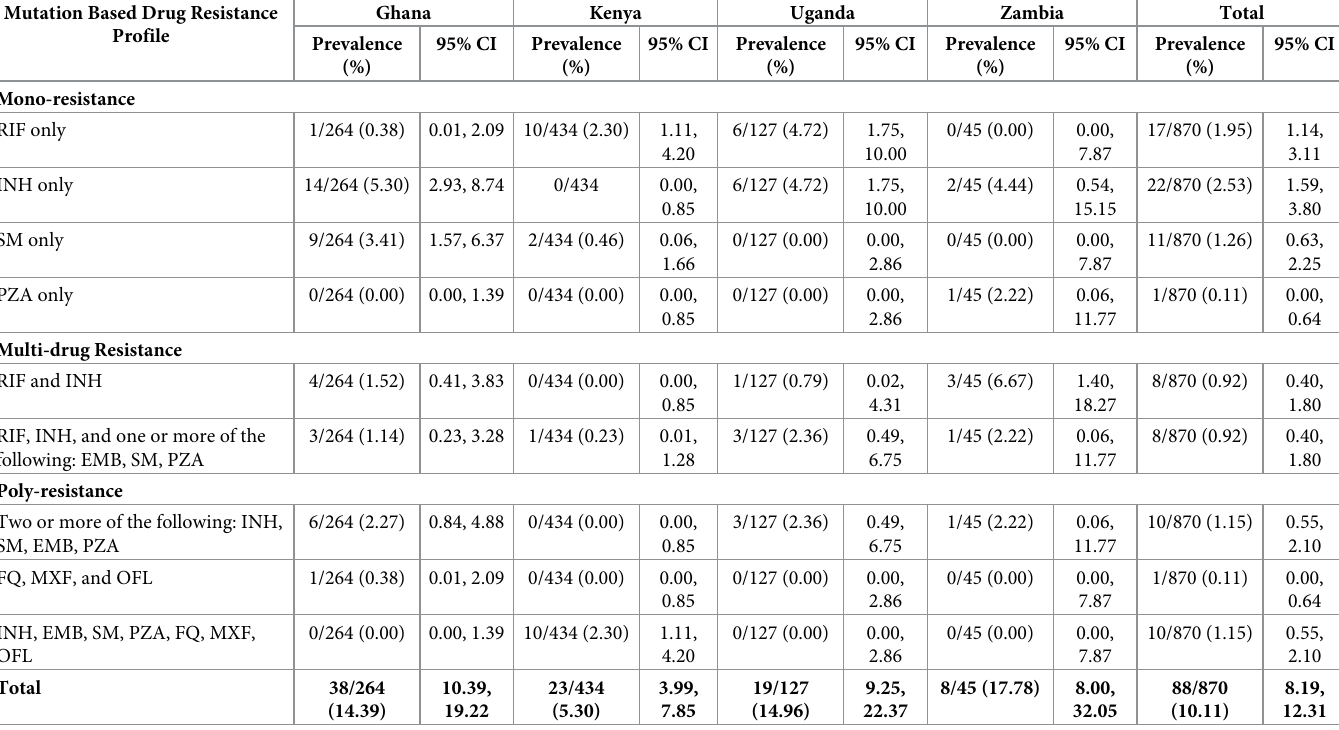
Table 4. Prevalence and 95% confidence intervals for detected drug resistance mutation profiles in smears with interpretable results for all target gene segments, stratified by country a . Mutation Based Drug Resistance